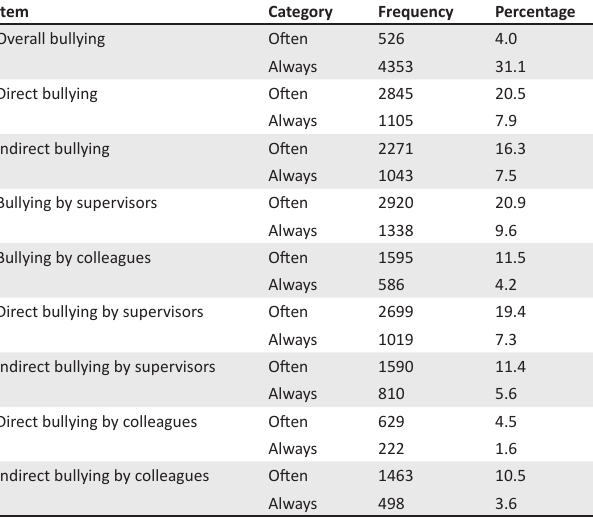
TABLE 3: Prevalence of workplace bullying.